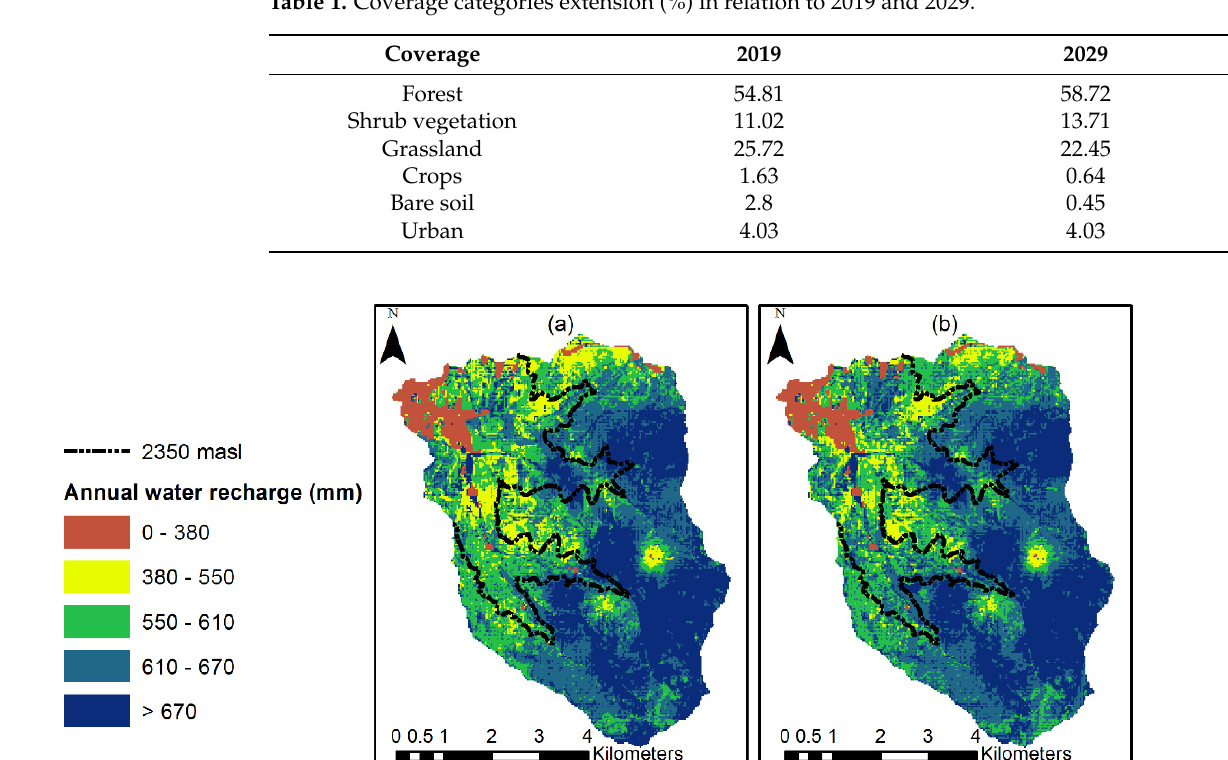
Table 1. Coverage categories extension (%) in relation to 2019 and 2029.